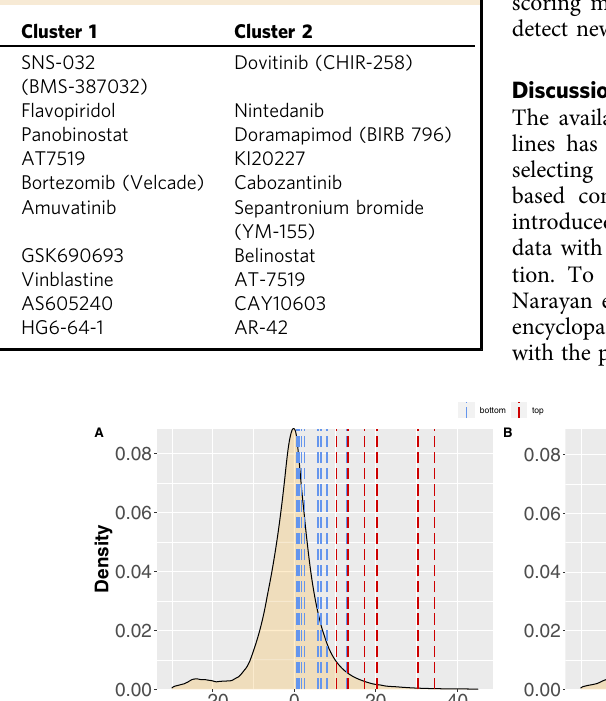
Table 1 Top fi ve small molecules in each cluster of DSNs.